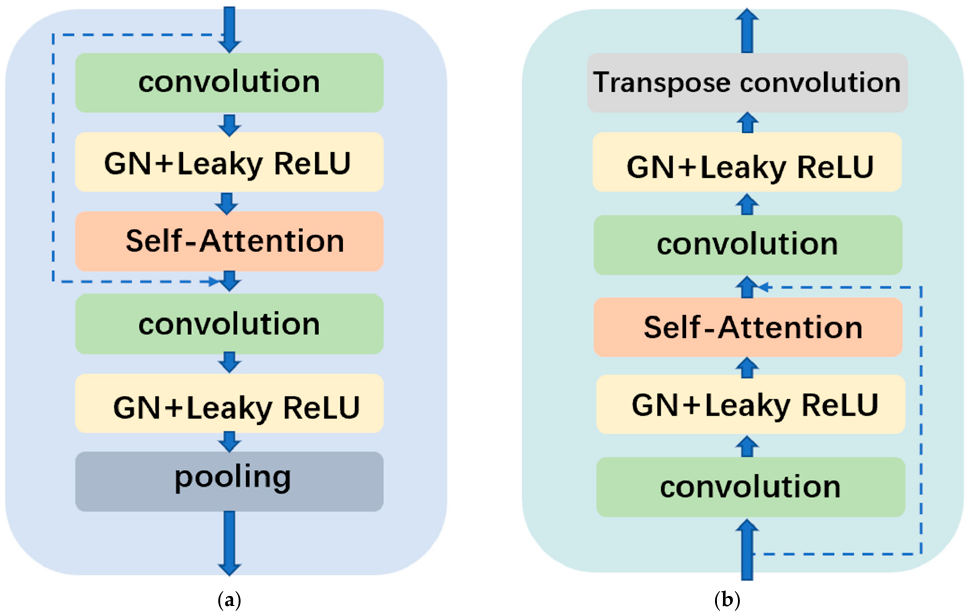
Figure 2. ( a ) Encoder module, using maxpooling to realize down sampling; ( b ) decoder module, using transconvolution to realize up-sampling.